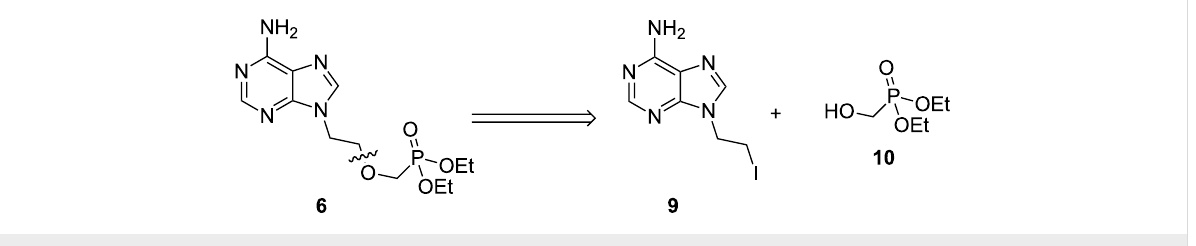
Figure 2: Retrosynthetic analysis of 6 to synthons 9 and 10